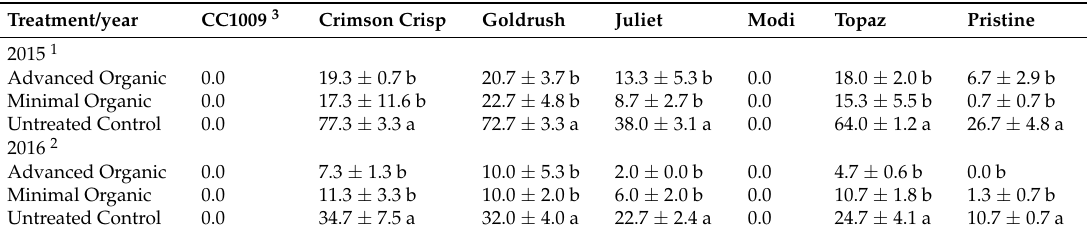
organic management programs, 2015–2016.